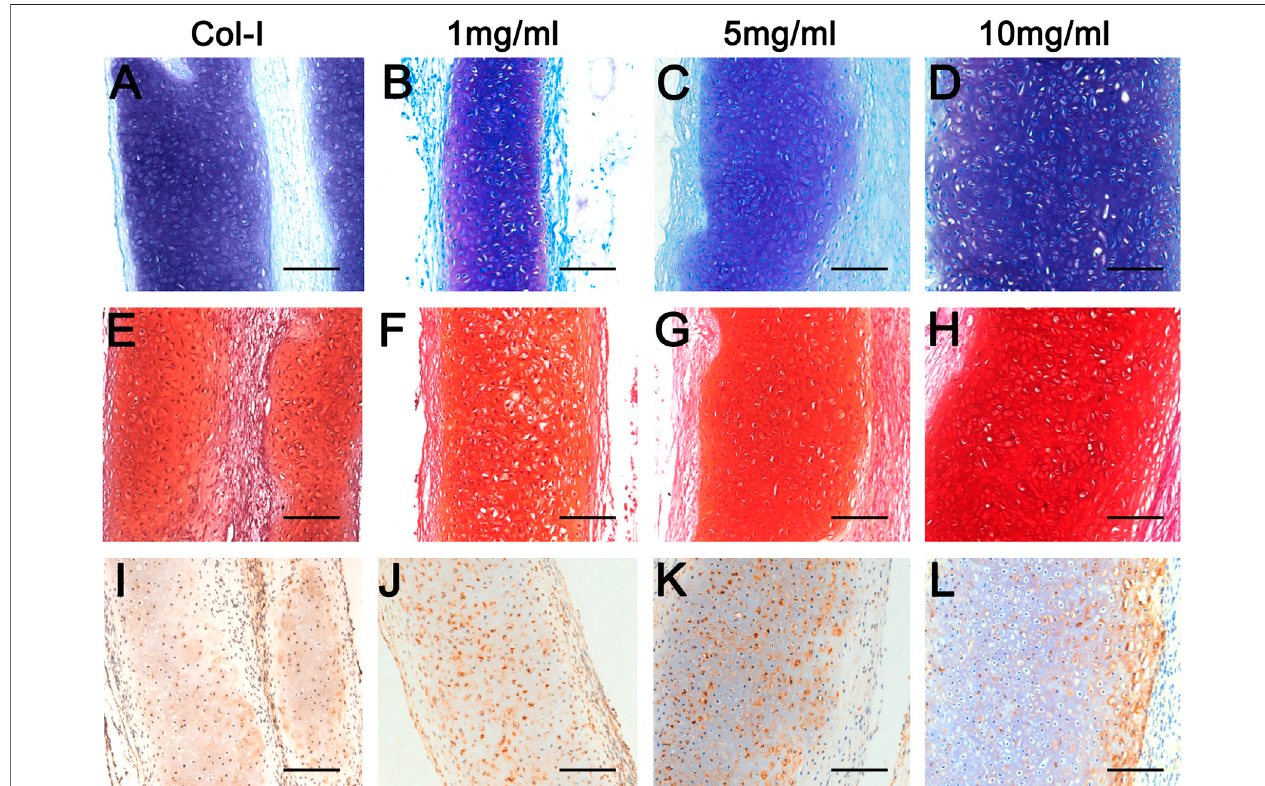
FIGURE 6 | Histological analyses of dcECM hydrogels at 4 weeks after grafting. Grafts were harvested and compared at 4 weeks after transplantation. (A – D) Histological analyses of the Col-I (A) , 1 (B) , 5 (C) , and 10 (D) mg/ml dcECM hydrogel grafts by Toluidine blue. (E – H) Safranin O staining of grafts from Col-I (E) , 1 (F) , 5 (G) ,and10 (H) mg/mldcECMhydrogels. (I – L) RepresentativeimagesofcollagenIIstainingofCol-I (I) ,1 (J) ,5 (K) and10 (L) mg/mldcECMhydrogelgrafts.Scalebars (cid:2) 100 μ